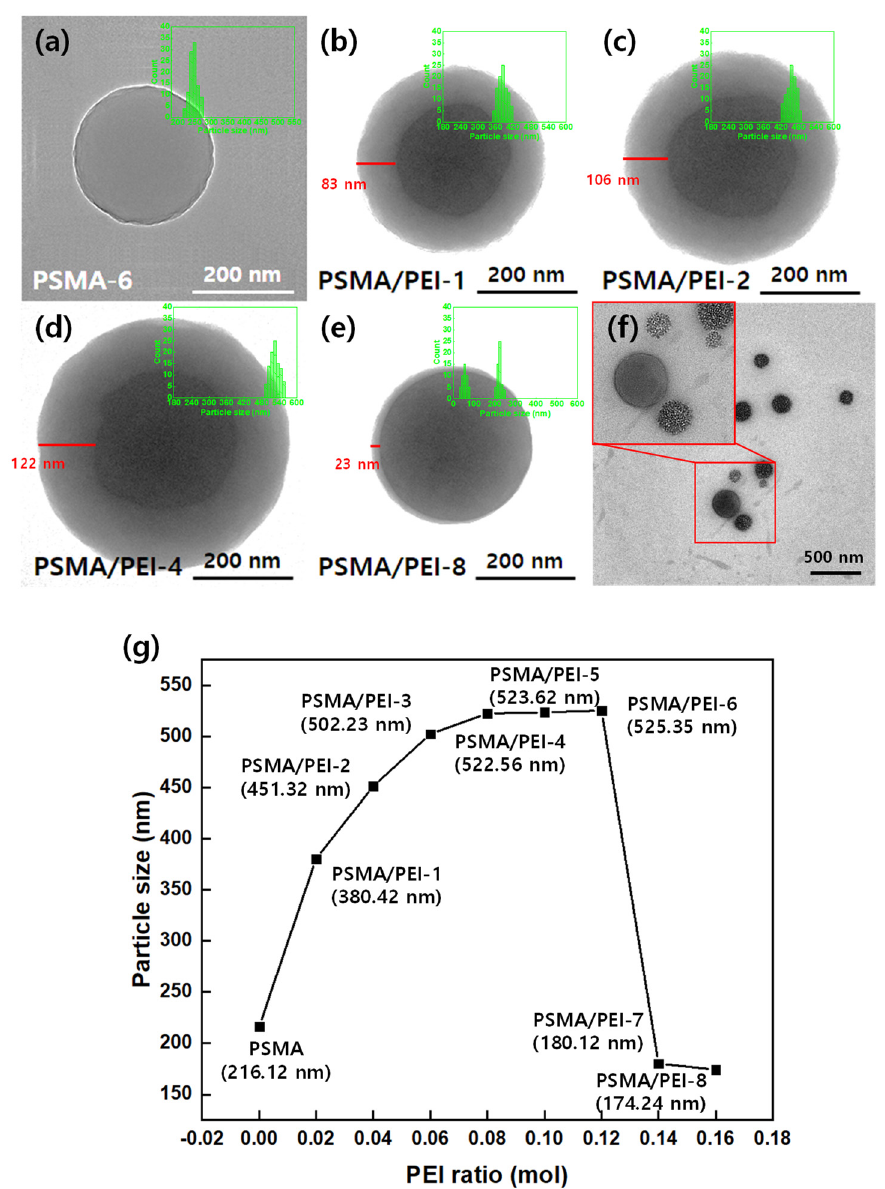
Figure 4. TEM images of PSMA/PEI core–shell nanoparticles with different shell thickness by the addition of PEI: ( a ) PSMA, ( b ) PSMA/PEI-1 (PEI = 0.02 mol), ( c ) PSMA/PEI-2 (PEI = 0.04 mol), ( d ) PSMA/PEI-4 (PEI = 0.08 mol), and ( e ) PSMA/PEI-8 (PEI = 0.16 mol); ( f , g ) dependence of particle size distribution on PEI amount in PSMA/PEI core–shell nanoparticles.